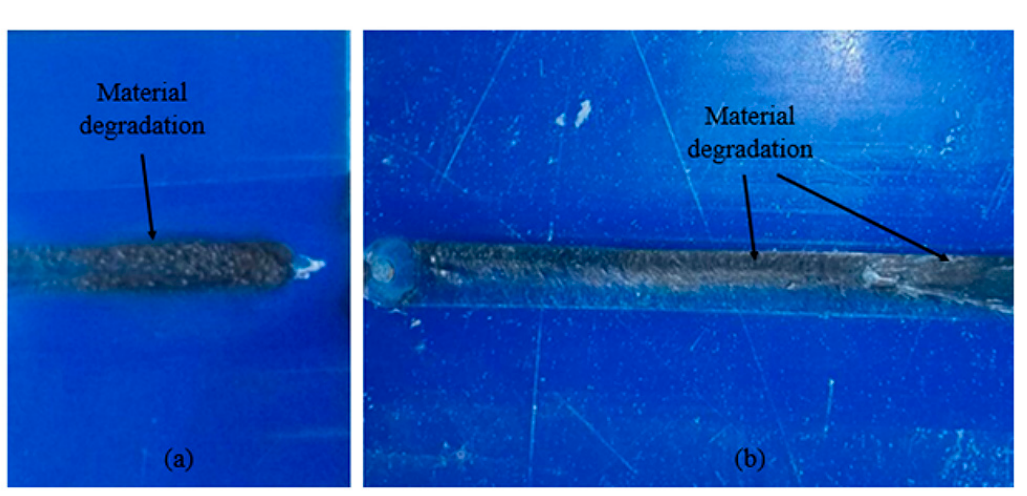
Figure 6. Material degradation in: ( a ) experiment 4 (at high T and high ω ) and ( b ) experiment 6 (at high ( T and ω ) and low f ).